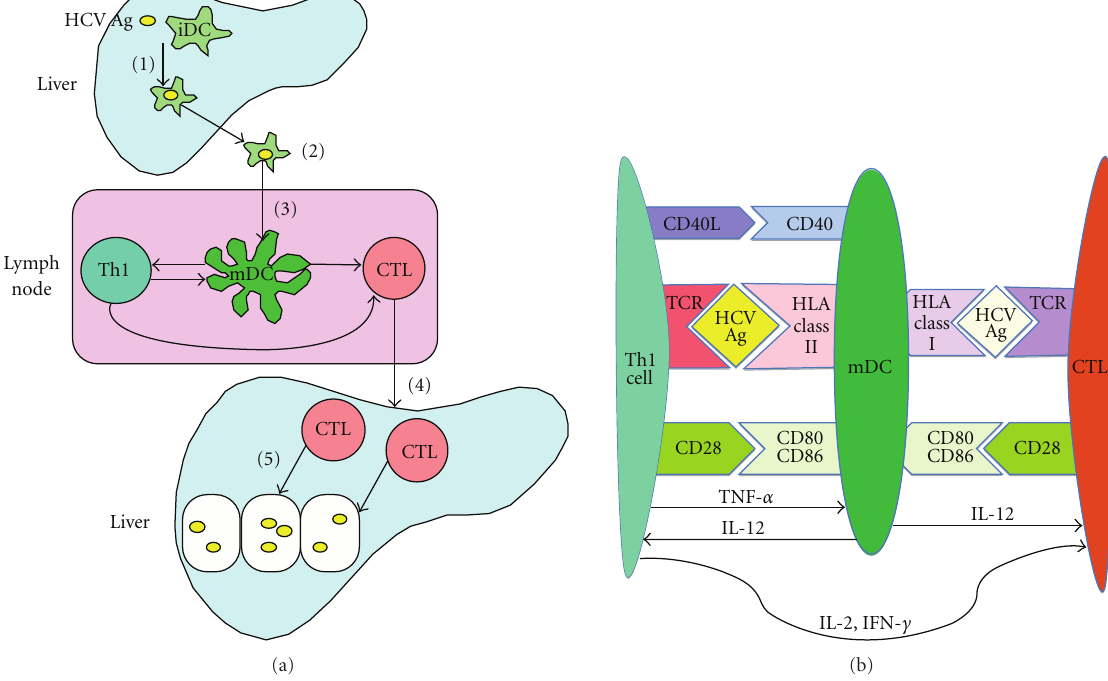
Figure 2: Destruction of HCV-infected hepatocytes by CTLs. (1) Immature myeloid dendritic cells (iDC) take up hepatitis C virus antigens (HCV Ag) in the liver. (2) The DCs move to a draining lymph node. (3) Matured DCs activate na¨ıve helper T (Th) cells e ffi ciently through stimulation with HLA class II, costimulatory molecules (CD80 and CD86), and cytokines such as IL-12. The stimulated Th cells, in turn, activate DCs by expressing CD40 ligand and secreting TNF- α . IL-12 produced by myeloid DCs di ff erentiates these stimulated Th cells towards Th1 cells. Na¨ıve cytotoxic T lymphocytes (CTLs) recognize the HCV Ag presented on the DCs. IL-2 and IFN- γ secreted by activated Th1 cells induce the activation and proliferation of the HCV-specific CTLs. (4) The stimulated HCV-specific CTLs leave the lymph nodes and move toward the liver. (5) They recognize HCV antigens together with HLA class I on the surface of HCV-infected hepatocytes, and try to eradicate HCV by killing the infected hepatocytes. Abbreviated terms: Th1 cell, type 1 helper T cell; mDC, myeloid dendritic cells; CTL, Cytotoxic T lymphocyte; CD, cluster of di ff erentiation; CD40L, CD40 ligand; TCR, T-cell receptor; HLA, human leukocyte antigen; TNF, tumor necrosis factor; IL, interleukin; IFN,